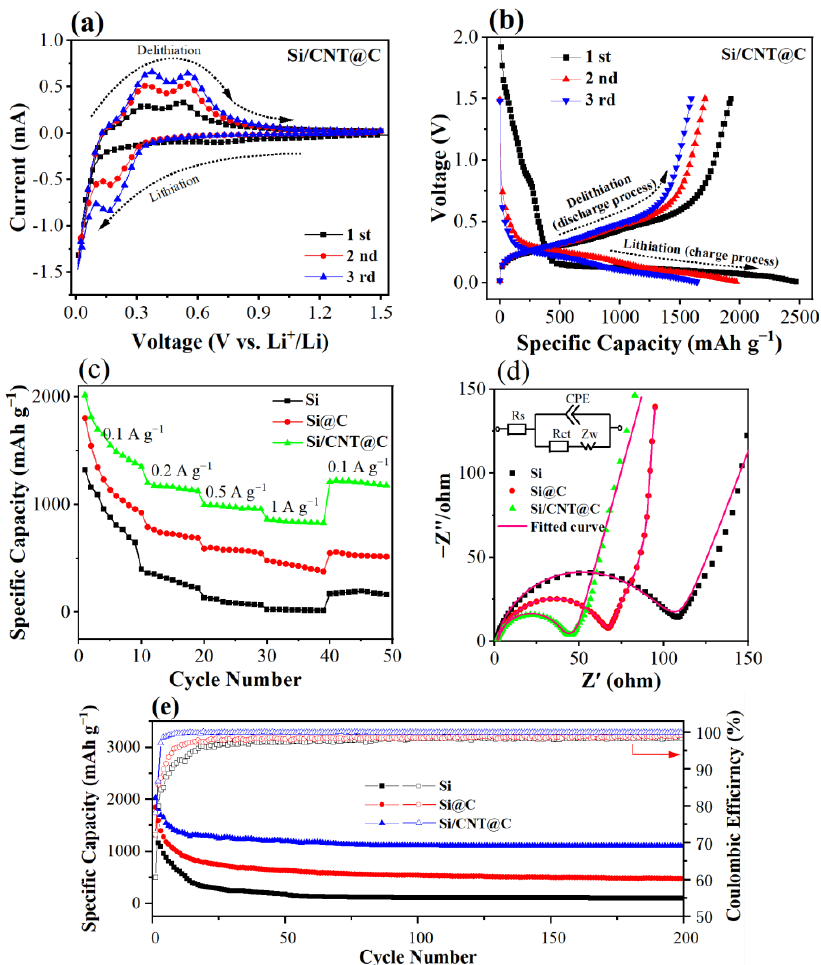
Figure 4. ( a ) CV curves of Si/CNT/C electrode at a scan rate of 0.1 mV s −1 . ( b ) Charge/discharge curves of Si/CNT/C electrode. ( c ) Rate performances of the bare Si, Si/C, and Si/CNT/C electrodes. ( d ) EIS curves (inset shows equivalent circuit) of the bare Si, Si/C, and Si/CNT/C electrodes. ( e ) Cycle performances of the bare Si, Si/C and Si/CNT/C